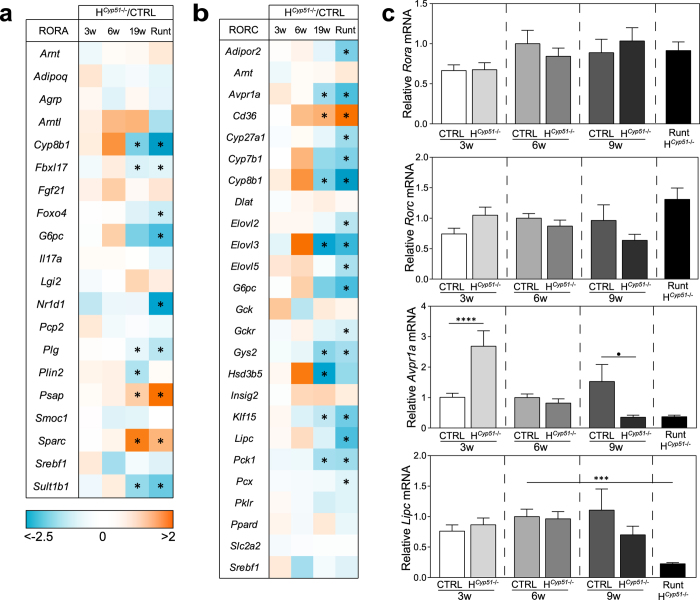
Cyp51 ablation results in dampened RORA and RORC activities in livers of runt and adult mice.(a) A heatmap of RORA target gene expression as measured by microarrays between HCyp51−/− and control (CTRL) mice on the wild type background at different ages. Runts were compared to 6-week controls. Decreased expression (blue); increased expression (orange). n = 4 (HCyp51−/−; CTRL); n = 6 (runts). (b) A heatmap of RORC target genes as measured by microarrays between HCyp51−/− and control mice on the wild type background at different ages. Runts were compared to 6-week controls. n = 4 (HCyp51−/−; CTRL); n = 6 (runts). (c) Relative gene expression of Rora, Rorc and RORC target genes – Avpr1a and Lipc – as measured by RT-qPCR in CTRL, HCyp51−/− and runt mice (n > 8), at different ages, on the wild type or heterozygous Cyp51 background. Columns depict means and error bars represent SEM. •p < 0.1; *p < 0.05; ***p < 0.001; ****p < 0.0001.